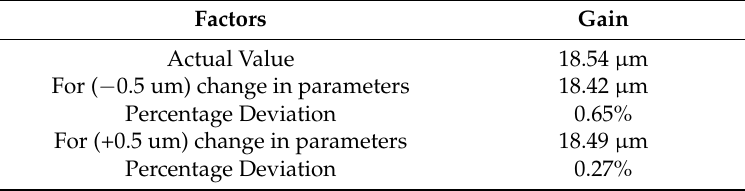
Table 5. Influence of parameter perturbation on the robustness of the prosed